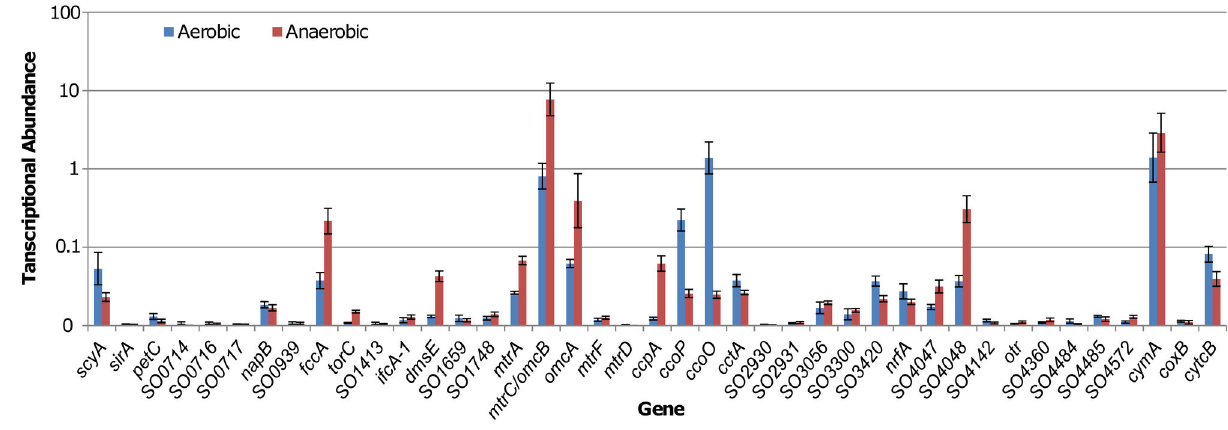
Figure 1. Expression of genes encoding c -type cytochromes in S. oneidensis . qRT-PCR analysis of RNA extracted from mid- logarithmic growing cells (OD , ~0.4 and ~0.15 for aerobic and anaerobic cultures respectively). All data were normalized to 600 expression of the arcA and recA genes, which were constant during the exponential growth phase. Numbers reported are standardized to expression of the arcA gene, but the same trends are observed when standardized to expression of the recA gene. Error bars represent standard deviation for triplicate cultures. SO1778 is displayed as mtrC / omcB because both names have been used in previous publications, but only mtrC is used in the rest of this article since it is accepted more widely. doi: